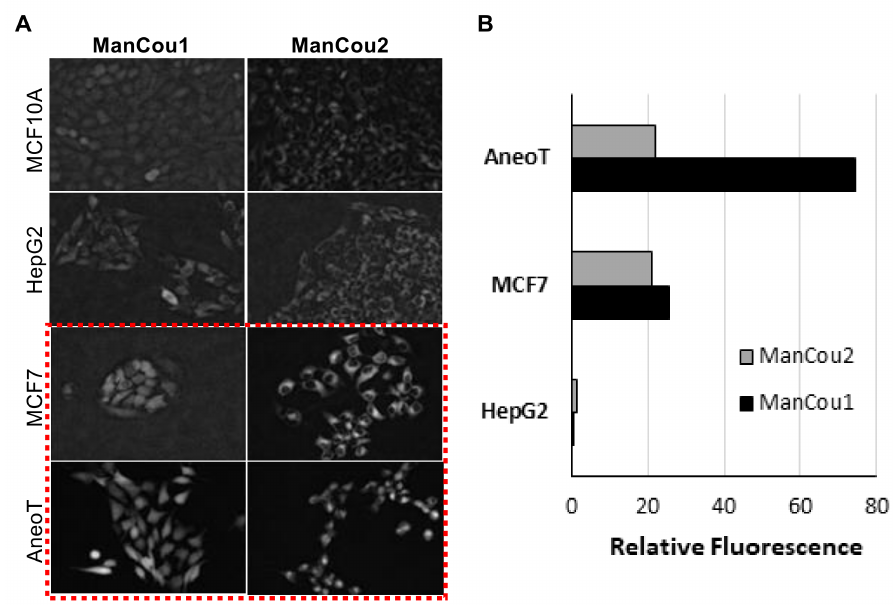
Figure 5. ManCou uptake in cells. ( A ) Grayscale fluorescence images of ManCou uptake in cells used